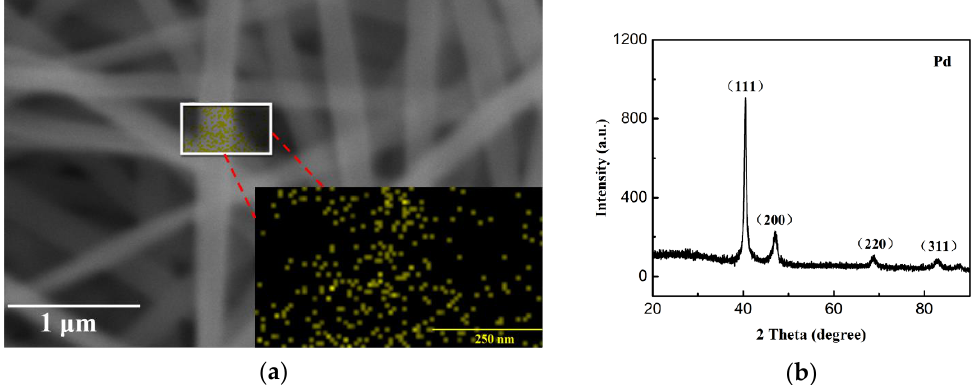
Figure 5. ( a ) Energy dispersive X-ray (EDX) mapping of the synthesized nanostructure, and ( b ) X-ray diffraction pattern of the synthesized nanostructure.